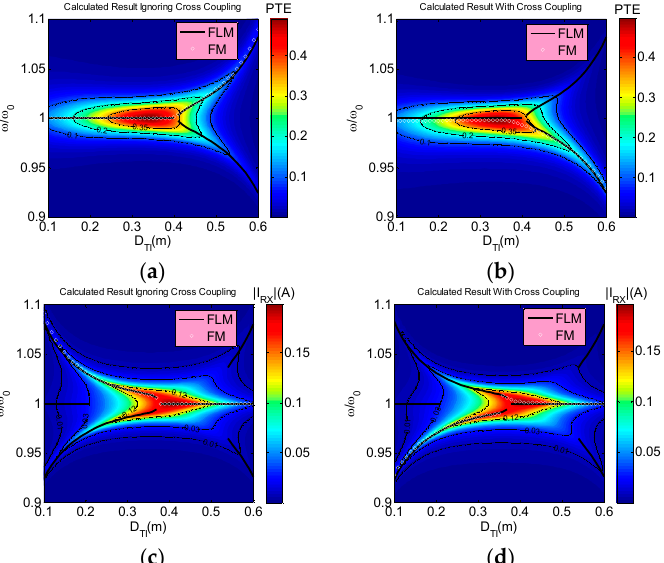
Figure 4. Parameters for judging transfer regions for PTE and PDL ( | I RX | ) when D TR = 0.7 m: ( a ) x j ( j = 0, 1 and 2) and ∆ vs. D TI from 0.1 m to 0.6 m; and ( b ) x j ( j = 1 and 2) and ∆ vs. local D TI .